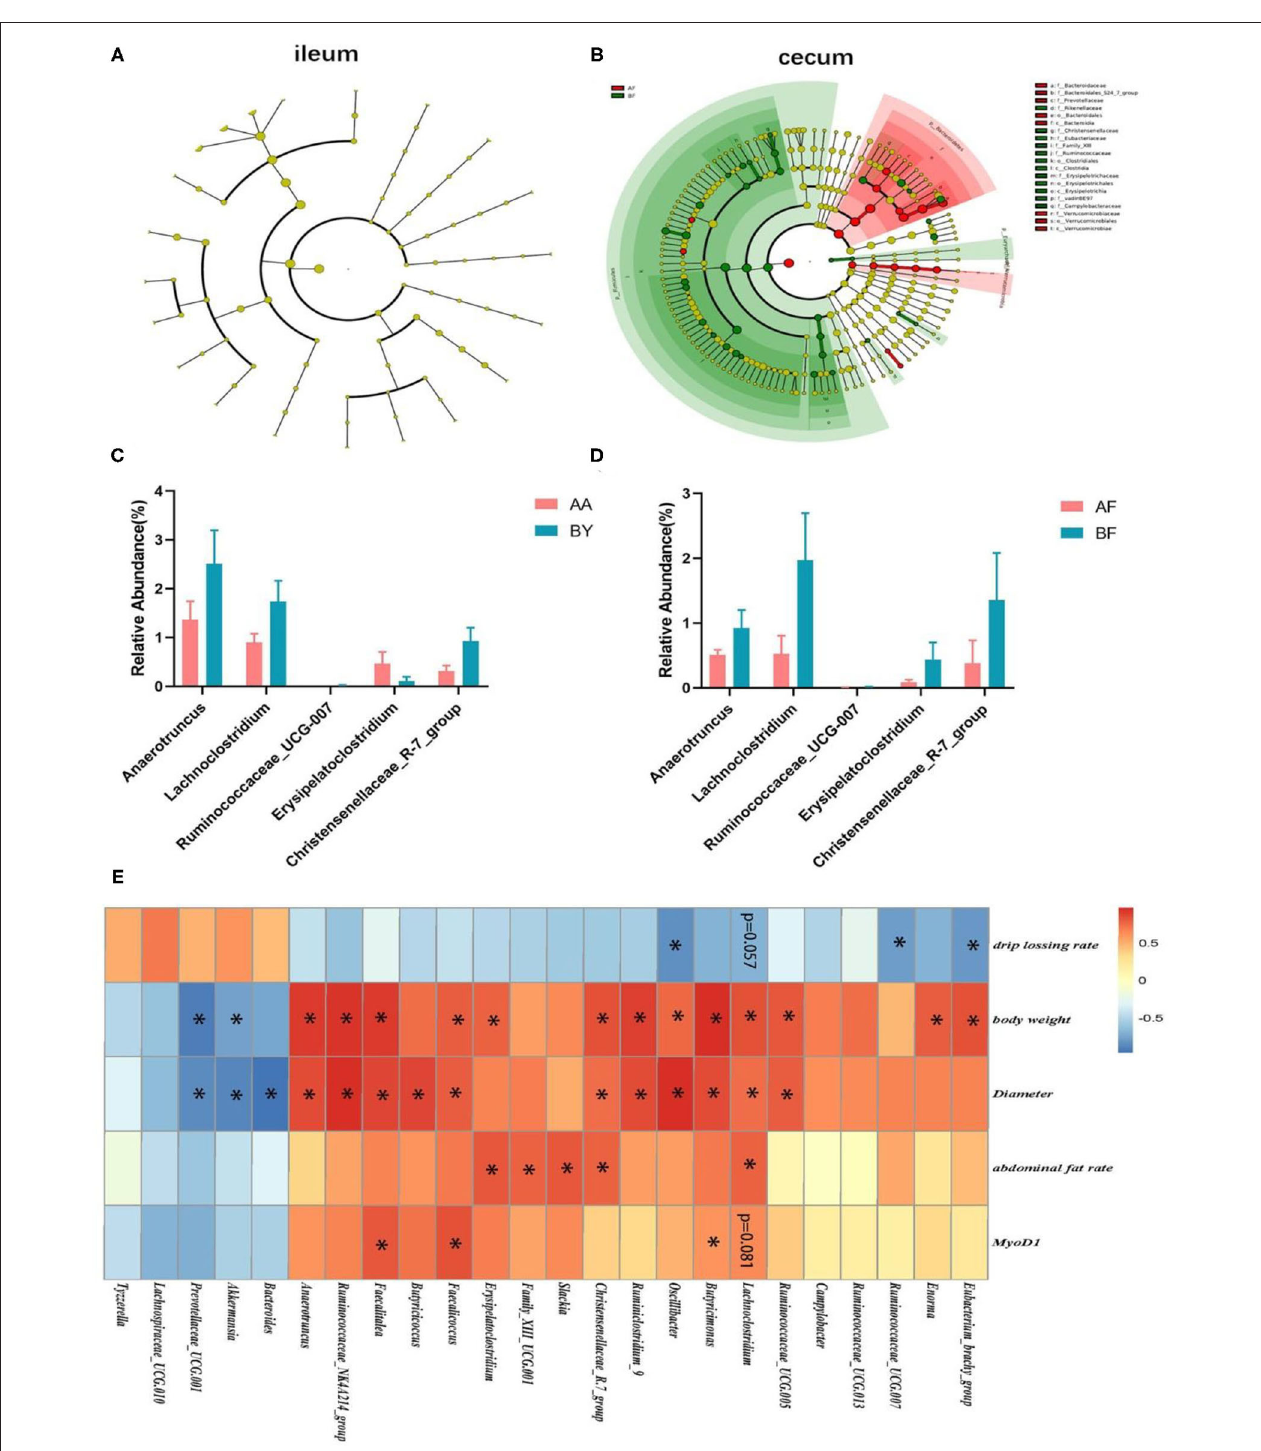
FIGURE 5 | Analysis of the correlation between cecum intestinal bacteria at the genus level and phenotypes. (A,B) Cladograms of different microbiota in the ileum and cecum in recipients. (C,D) Bacteria (genus level) discovered in the cecum of both the donors (C) and receptors (D) ; (E) The heat map of the correlation analysis between different bacteria in cecum and phenotypes. AF: Fecal transfer from the Arbor Acres broilers into the Arbor Acres broiler; BF: Fecal transfer from the Beijing-You broilers into the Arbor Acres broilers. The numbers of independent biological samples analyzed in (A–H) were AF ( n = 5) and BF ( n = 5). All the data are expressed as mean ± SEM. All the data were analyzed using ANOVA, followed by the Tukey’s test, and were considered as statistically significant at * p < 0.05 between the indicated groups.